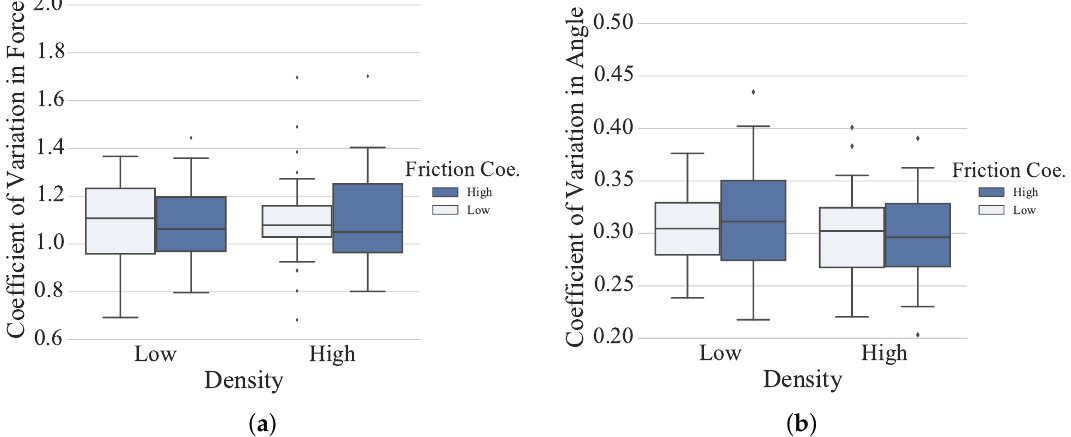
Figure 13. ( a ) The coefficient of variation of mean grip force across all conditions in box plot; ( b ) The coefficient of variation of max grip angle across all conditions in box